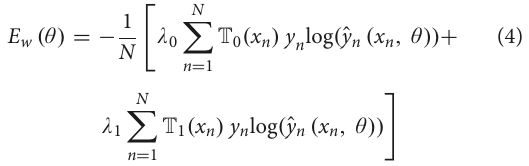
FIGURE3 Configuration of the UNet architecture to predict the segmentation mask that marks of the regions of the scar, the myocardium and left ventricle (LV) cavity. The input image is a set of 32 frames of cine SAX image frames. The ground truth (output image) consists of an image with four channels, namely, the background (label = 0), the myocardium (label = 1), the LV cavity (label = 2), and the scar (label = 3).